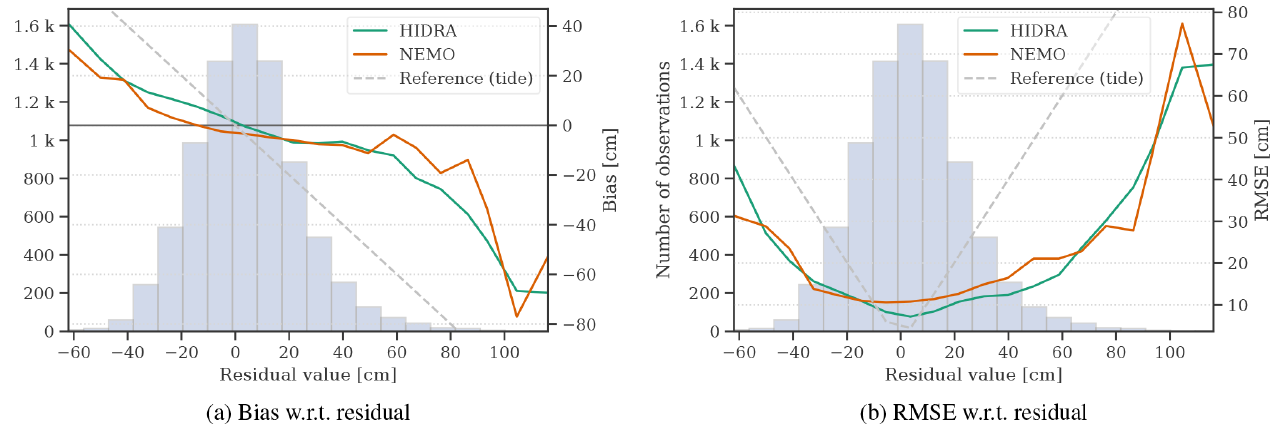
Figure 9. Comparison of HIDRA and NEMO over the sea level distribution. Bias (a) and RMSE (b) with respect to the residual value are shown. Error of the astronomic tide is shown for reference.